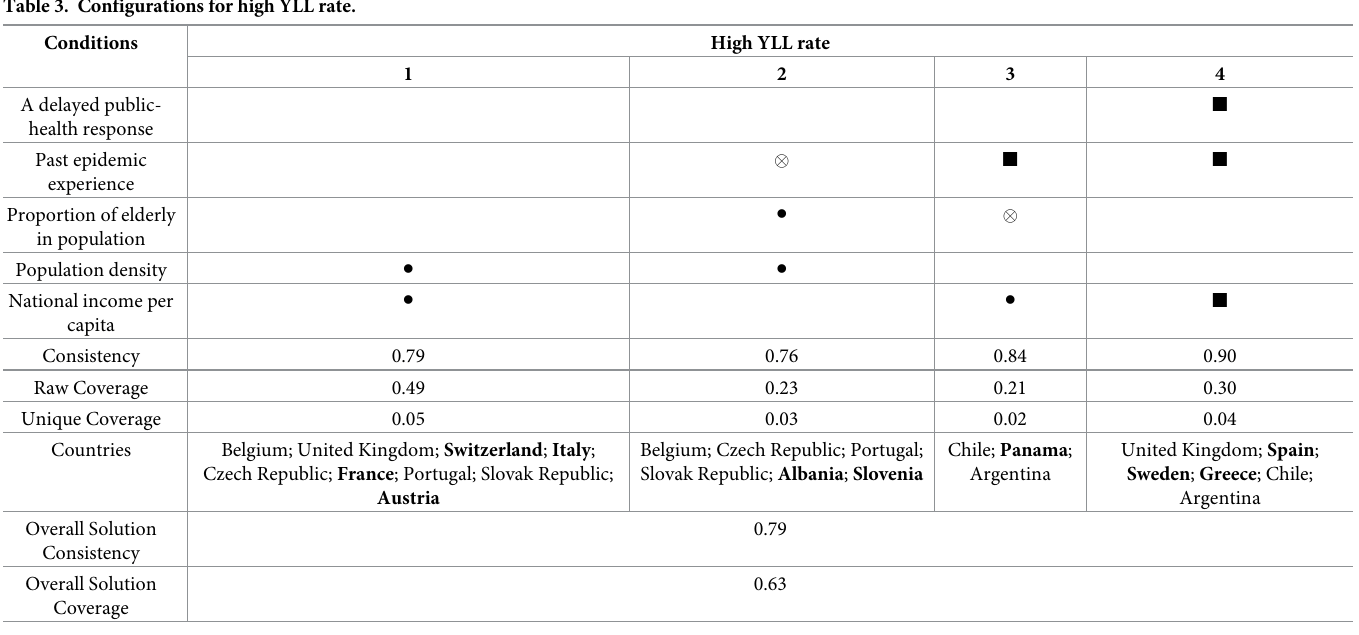
Table 3. Configurations for high YLL rate.